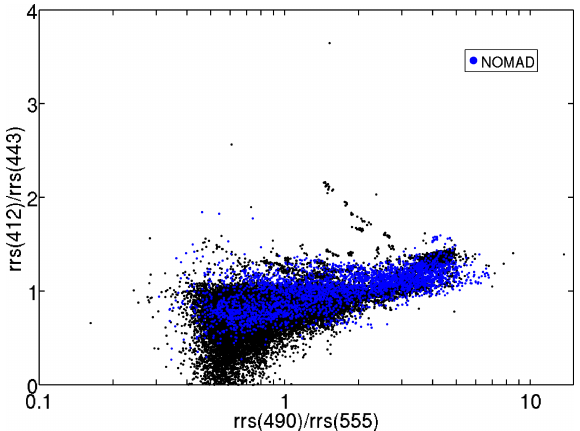
Figure 4. Ranges of remote-sensing reflectance band ratios (412:443 and 490:555) for all data. The points from the NOMAD dataset are shown in blue for reference. To maximize the number of ratios per dataset a search window up to 12nm was used, when the four wavelengths (412, 443, 490, 555) were not simultaneously available. The effect of different search windows was negligible in the ratio